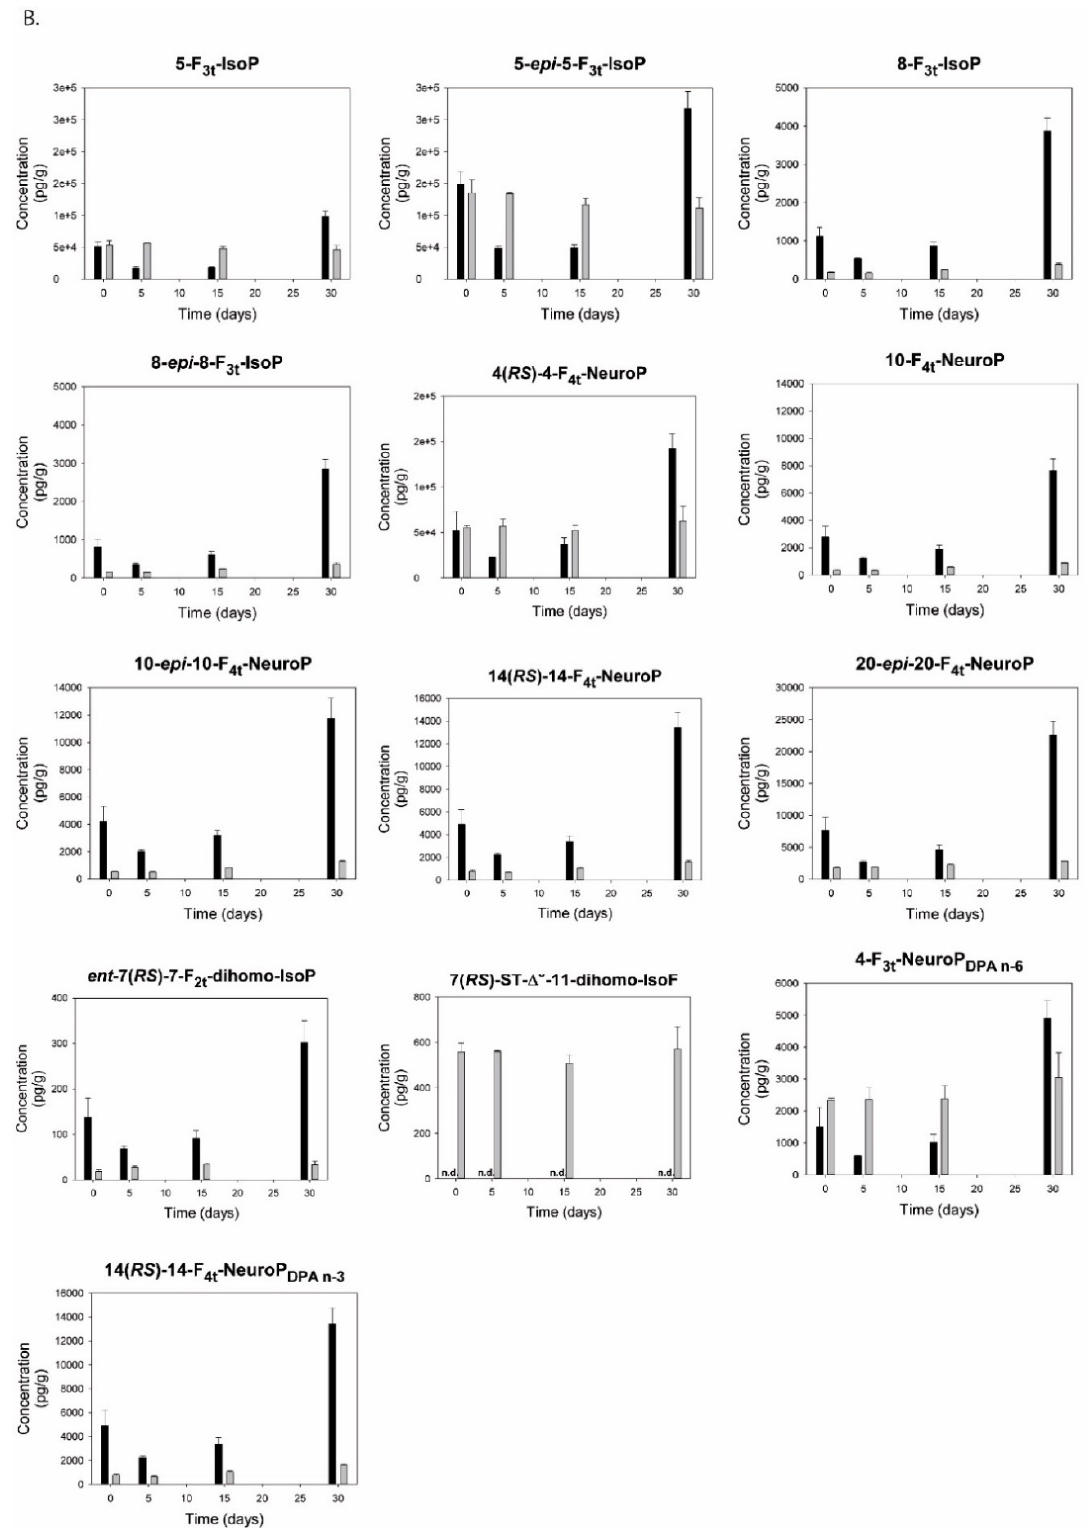
Figure 5. ( A ) Temporal changes of phytoprostanes and arachidonic acid-derived isoprostanes in hoki liver oil (black bars) and anchovy oil (gray bars) during a 30-day incubation under oxidation Condition A. Results are means ± S.D. of three technical replicates for one incubation. ( B ) Temporal changes of EPA-derived isoprostanes, DHA-derived neuroprostanes, adrenic acid (AdA)-derived dihomo-isoprostanes and furans, and DPA n-6- and DPA n-3-derived neuroprostanes in hoki liver oil (black bars) and anchovy oil (gray bars) during a 30-day incubation under oxidation Condition A